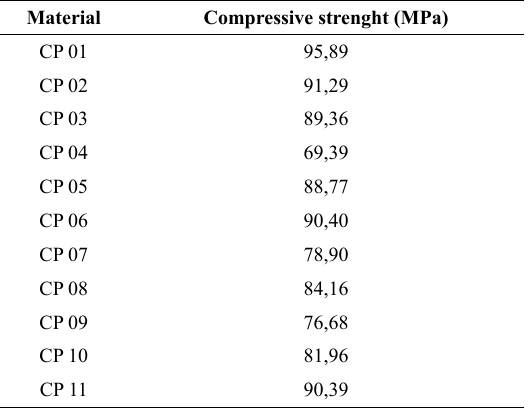
Table 2. Compressive strength values for the artificial stone produced.